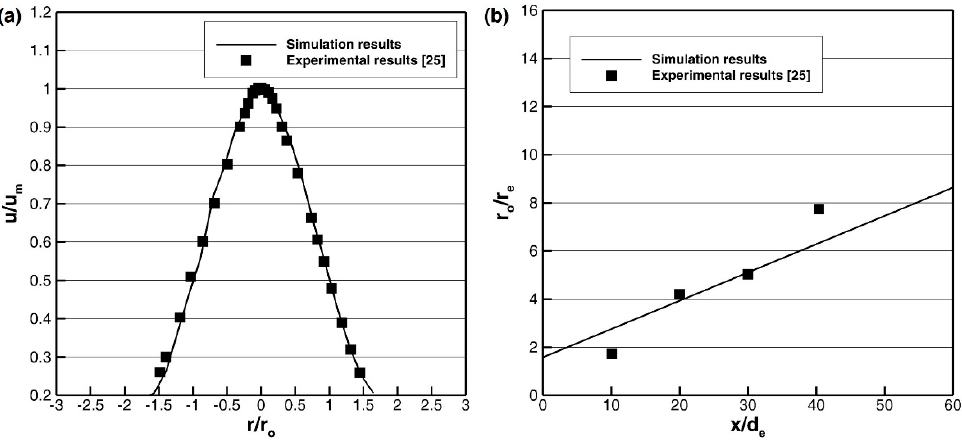
Figure 5. Validation of ( a ) radial velocity profile and ( b ) jet radius at half-maximum velocity.